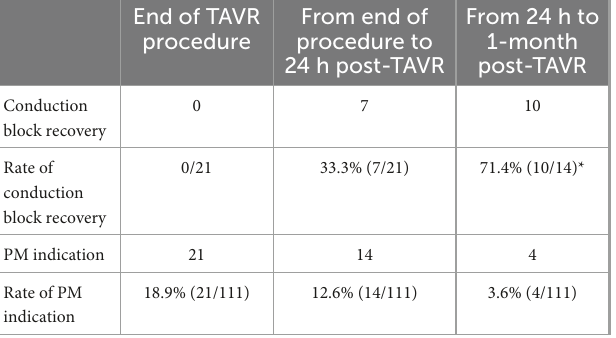
High-degree AVB (HAVB) may be mitigated by PPM within 30 days after TAVR, and no adverse effect was detected in the incidence of 30-day heart failure readmissions or all-cause mortality.